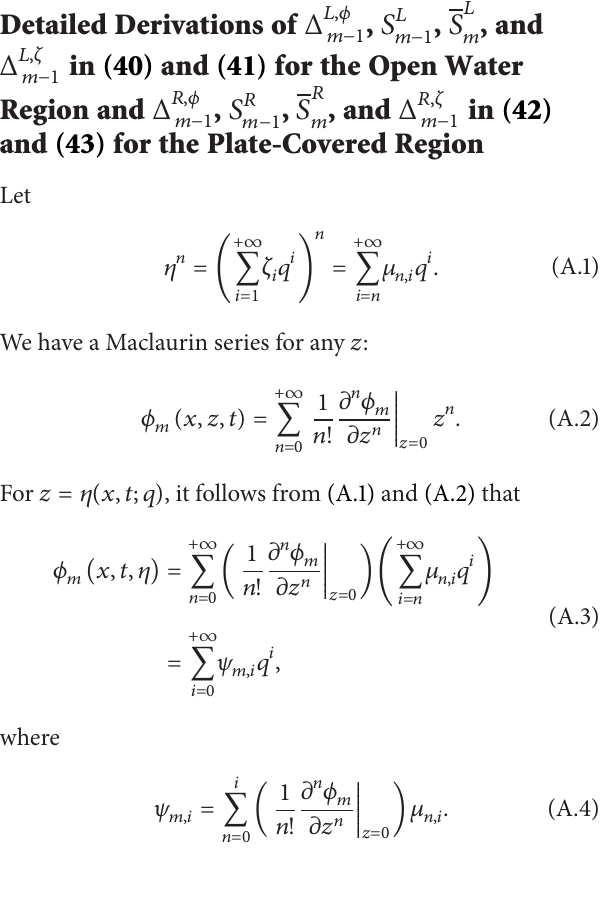
. Solid e = 0.5 × 10 3 kgm −3 ; dash- e